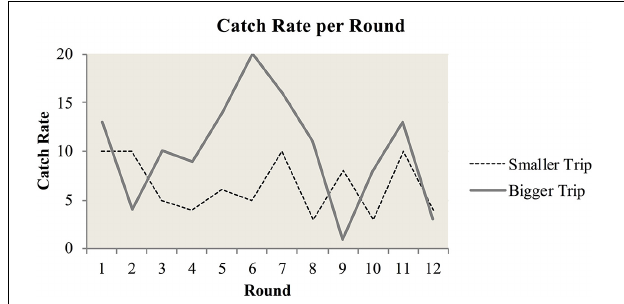
FIGURE 5 | Catch rate per round for the trip with the smaller loan and the big loan. The catch ratings for each type of trip where drawn at random from a lottery before the experimental sessions took place and remained the same throughout all